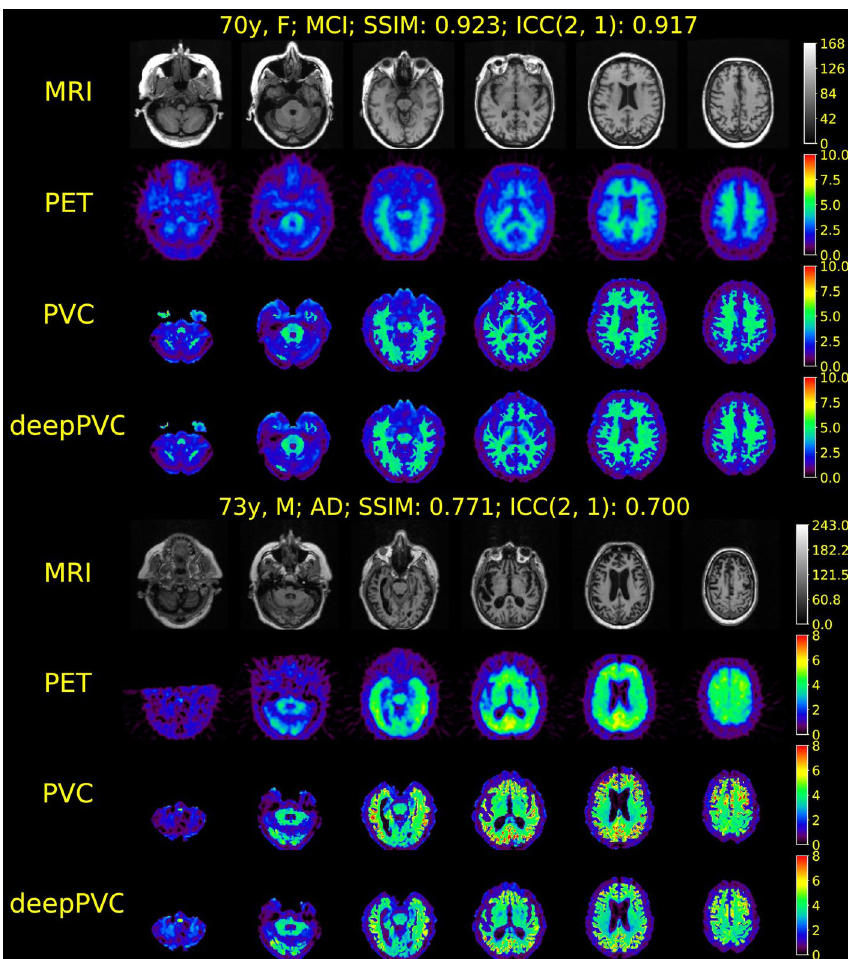
Fig. 5 MR, PET, and real and predicted PV-corrected maps for cases with the best (top) and worst (bottom) SSIM among the [ 11 C] PiB test data. MR, magnetic resonance; PET, positron emission tomography; PV, partial volume; SSIM, structural similarity